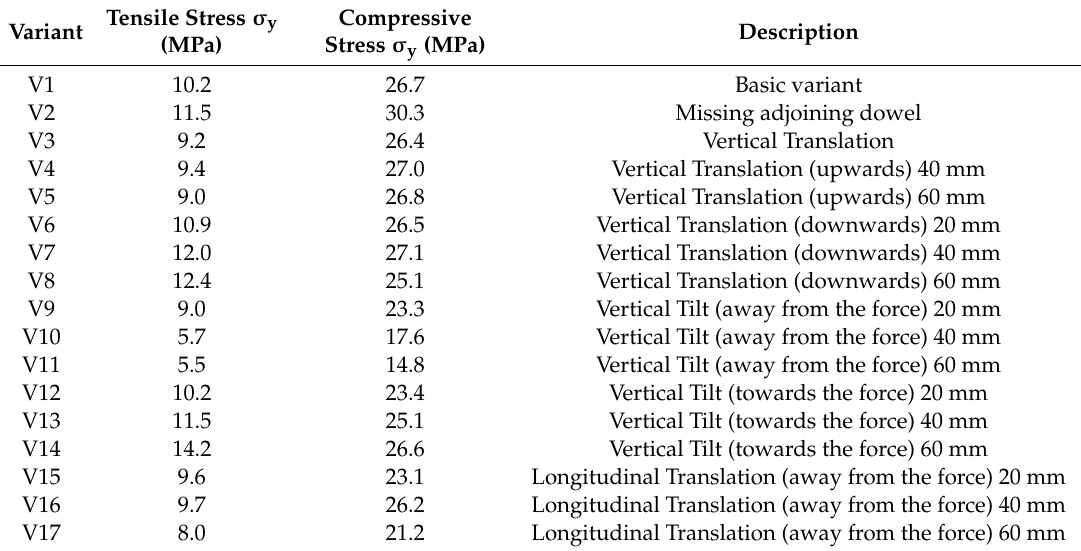
Table 5. Results of stress around